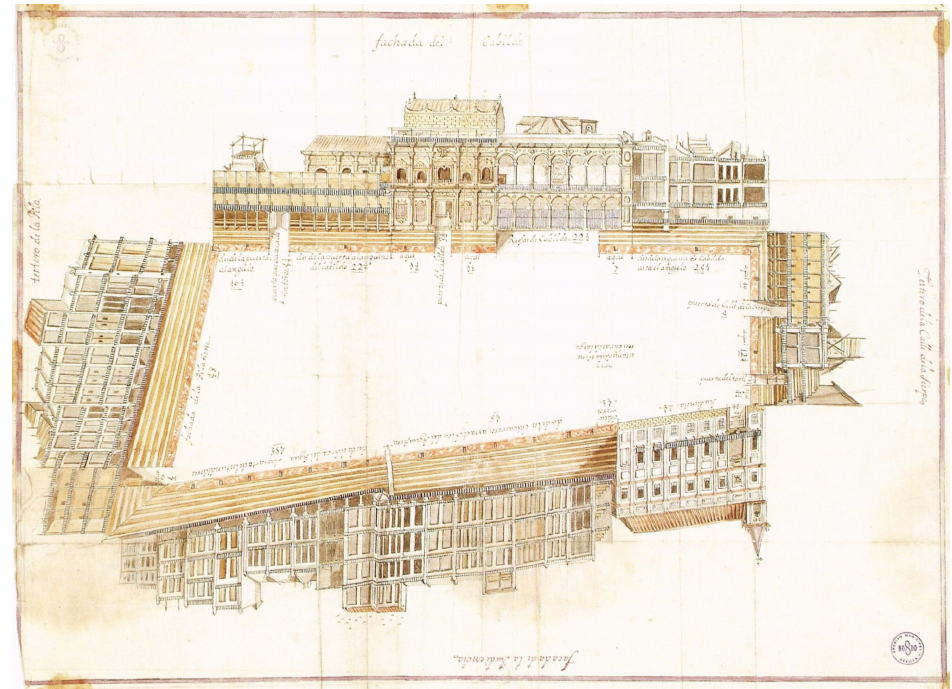
Figure 12. Plan of the Plaza de San Francisco made with the tribune for bullring in Seville. Source: